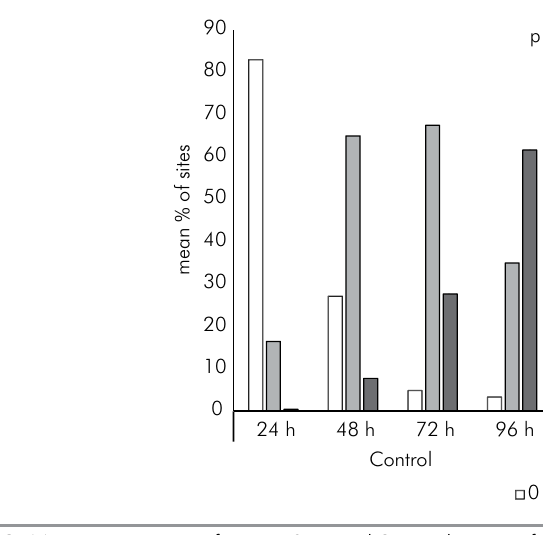
Figure 2. Mean percentage of scores 0, 1 and 2, in relation to facial surfaces in each experimental period.